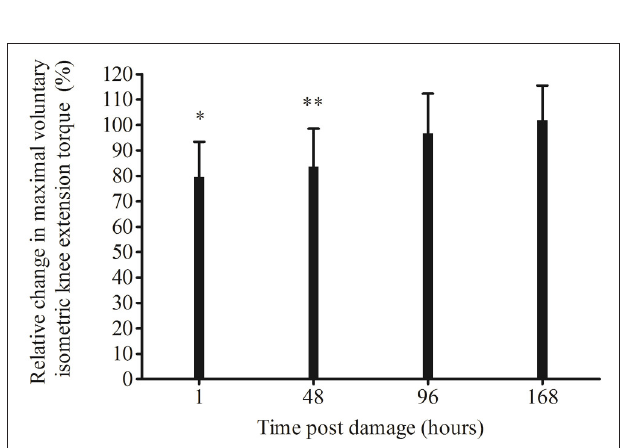
FIGURE 3 | Relative change in maximal voluntary isometric knee extension torque following exercise-induced muscle damage. Significantly lower than pre * p < 0.001, ** p <